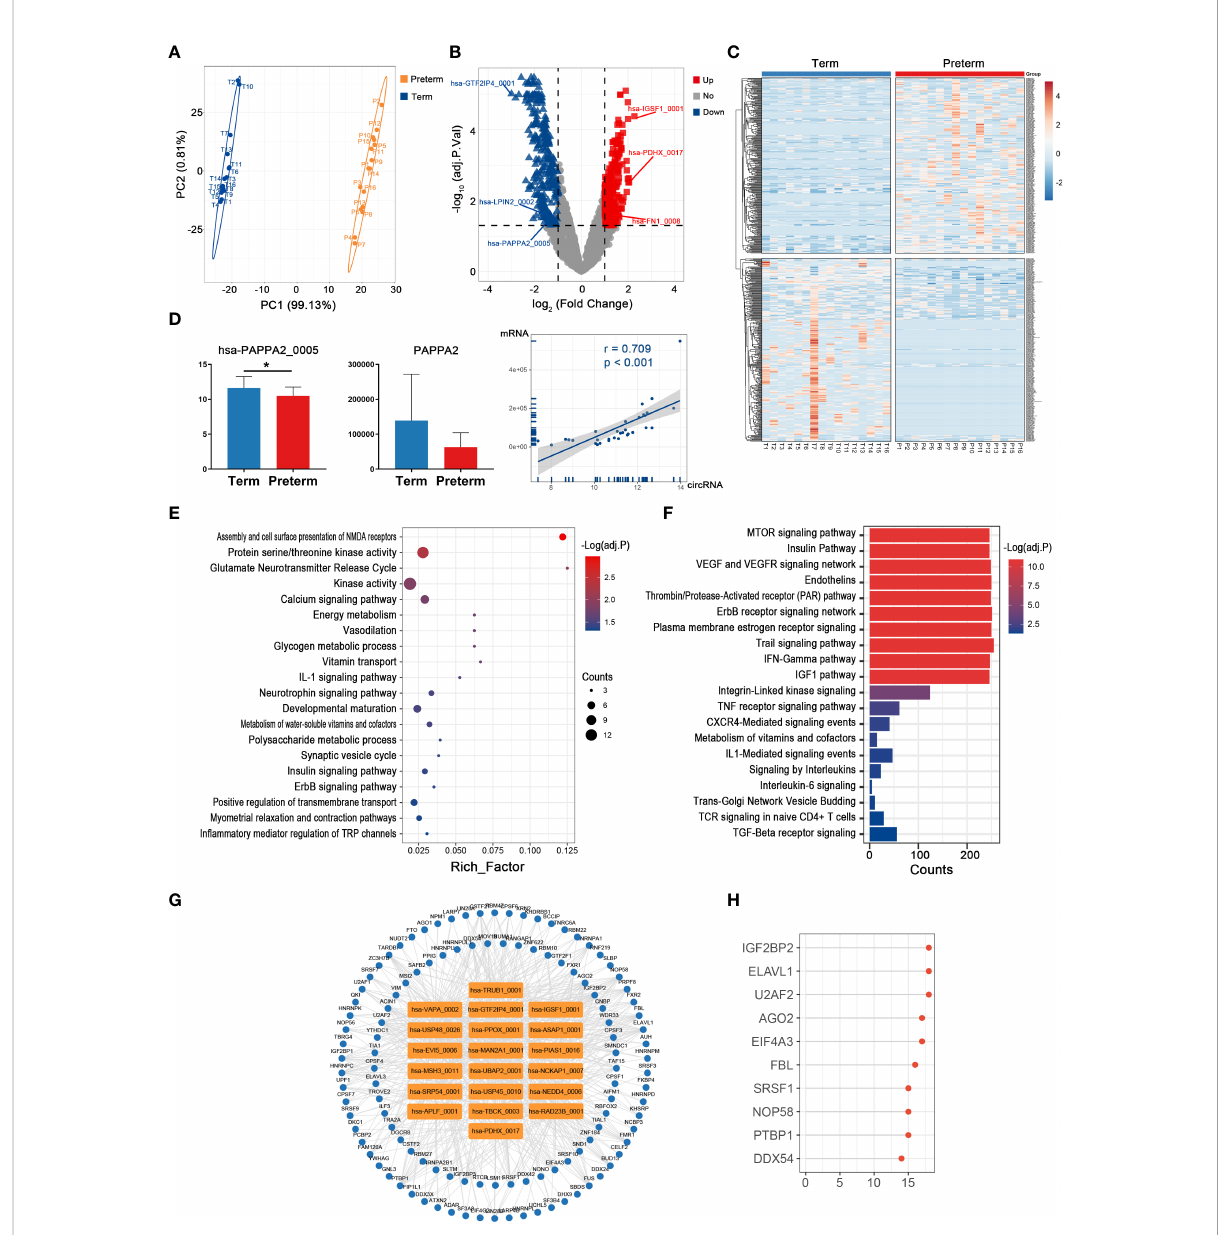
FIGURE 6 The circRNA changes and functional analyses in the placenta of PTB. (A) PLS-DA of circRNA expression in preterm (yellow points) and term (blue points) placenta. (B) The volcano plot of circRNA changes and adj. p-values in the placenta of PTB. (C) The hierarchical clustering of DECs expression in term and preterm placenta. (DECs: |log2 (fold change)|> 1 and adj. p-value < 0.05). (D) The expression levels of hsa-PAPPA2_005 and its host gene PAPPA2 between term and preterm placentas and their correlation. (* indicate p < 0.05) (E, F) Functional enrichment analysis for co-expressed mRNAs (E) and target miRNAs (F) of DECs in the preterm placenta. (G, H) The DECs-RBPs network and top 10 RBPs in the